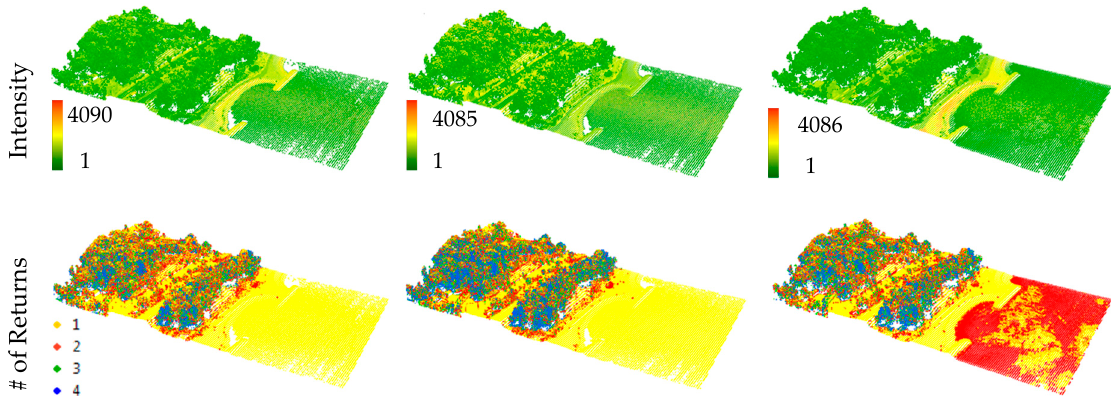
Figure 2. Light Detection and Ranging (LiDAR) point clouds from the three channels for a subset of the study area colored by elevation; intensity; and number of returns.